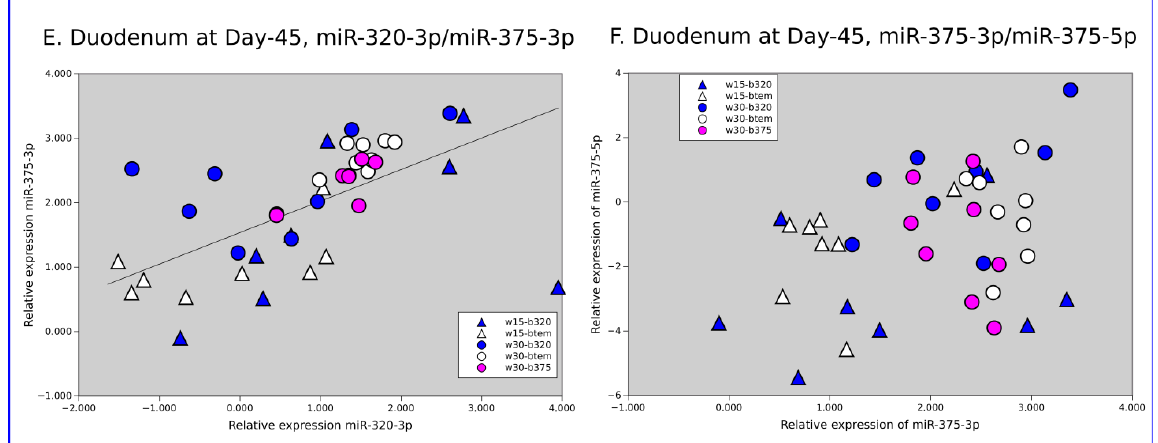
Figure 7. Long-term effects of miR-375-3p/DOSP followed by regular weaning on the density of CCK+GFP+ duodenal cells ( A , p < 0.05), on the level of chromogranin A transcripts ( B , p < 0.01). No difference was observed in miR-320-3p and miR-375-3p expressions in the stomach ( C ) and duodenum ( D ). Scatter plots between miR-320-3p/miR-375-3p and miR-375-3p/miR-375-5p are shown in ( E ) and ( F ), respectively. In ( E ), low correlation (R 2 = 0.54, black line), and in ( F ), the miR-375-5p levels of w15-b320 were downregulated in comparison with w30-b320 ( p = 0.02), and w30-btem ( p = 0.04). The light gray background indicates that rats were sacrificed in the dark phase. Note: * p < 0.05; ** p <